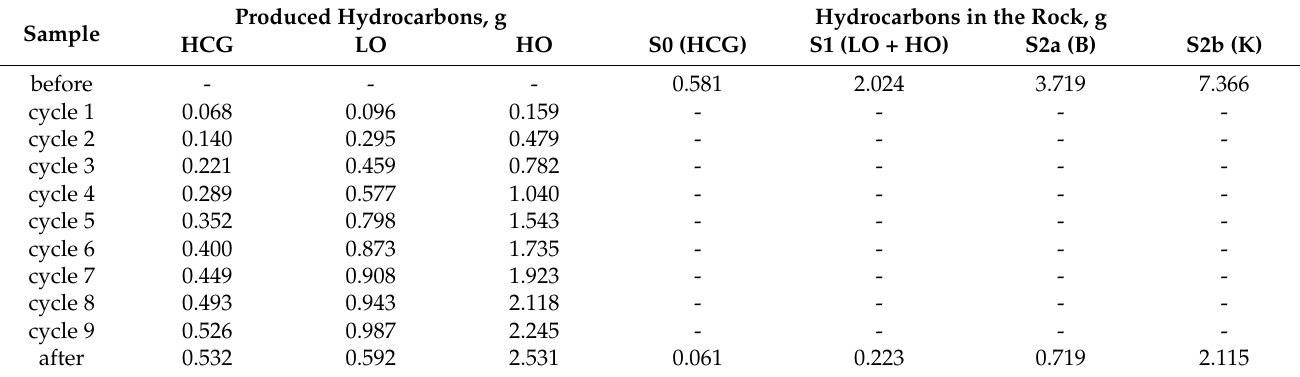
Table 2. Cumulative masses of produced hydrocarbons (left) and organic matter distribution in the oil shale before and after the experiment based on Rock-Eval pyrolysis results